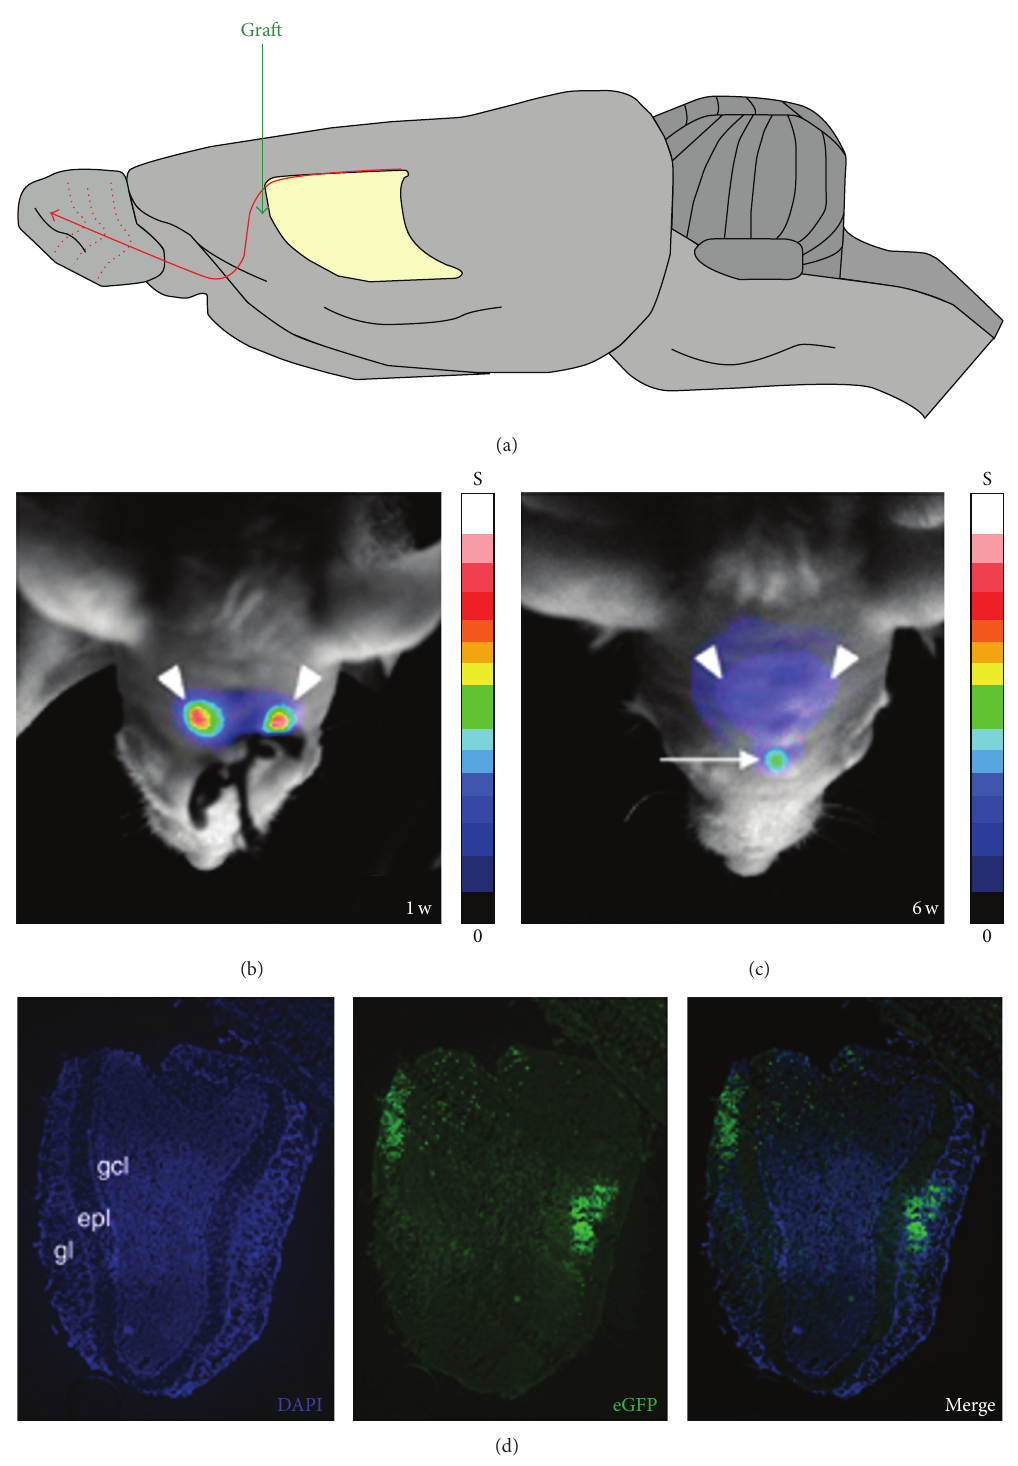
Figure 5: Tracking of NSC migration by in vivo optical neuroimaging. (a) Diagram showing the rostral migratory stream of endogenous NSCs, from the subventricular zone to the olfactory bulb. (b) Optical neuroimage of c17.2/Luc-NSCs transplanted in the mouse rostral migratory stream, acquired 1 week after grafting. (c) Bioluminescent spot (arrow) detected over the olfactory bulb of the same mouse 6 weeks after grafting. The arrowheads indicate the grafting sites. (d) Histological analysis showing eGFP-positive c17.2/Luc-NSCs in the olfactory bulb. Counterstaining with DAPI (blue) shows the presence of eGFP-expressing cells in the glomerular and granular cell layers, the natural migration target for NSCs of the subventricular zone ( 𝑛 = 3 )